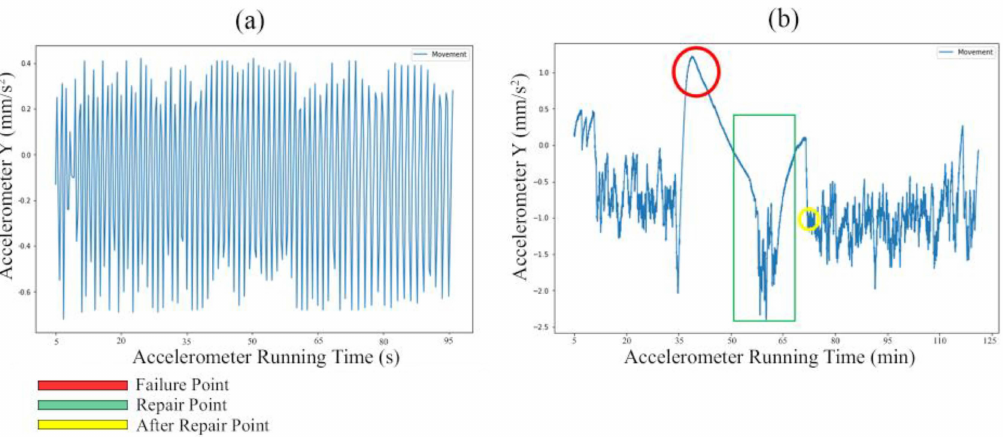
Figure 8. Graphs of sample cyclic vibration data in ( a ) normal condition, ( b ) failure